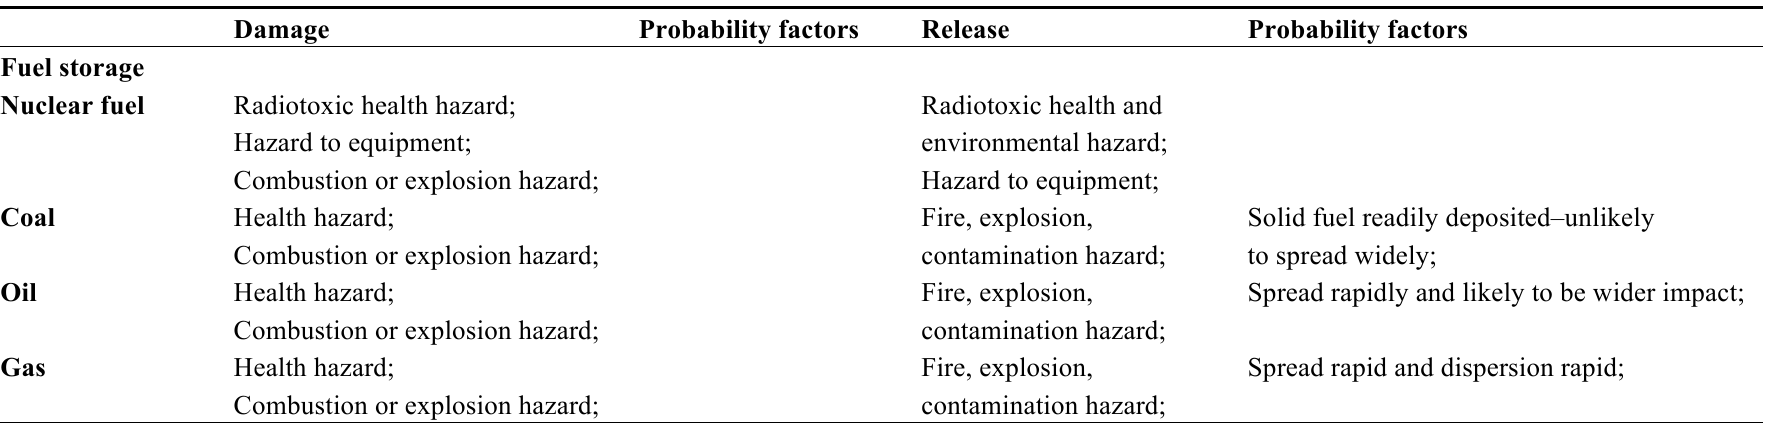
Table A3. Adapted-HAZOP assessment of risks associated with internal operations of energy systems (blank = not